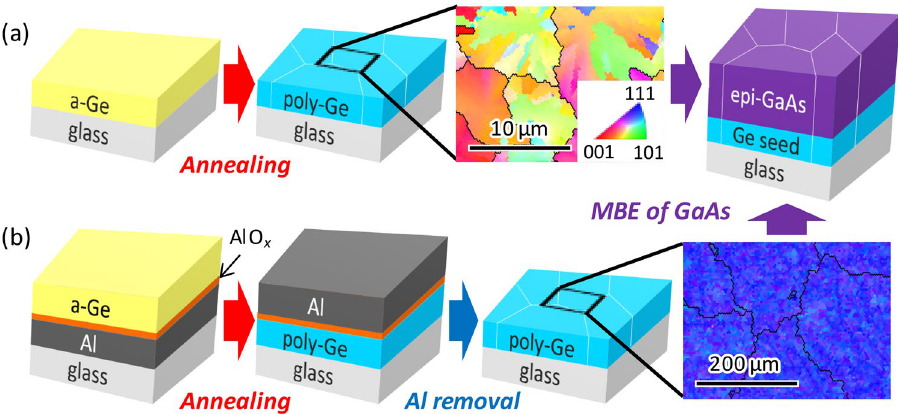
Figure 1. Schematic of sample preparation. ( a ) Samples in Groups A–C using SPC-Ge seed layers and ( b ) samples in Group D using ALILE-Ge seed layers. Representative crystal orientation maps of SPC-Ge (Sb-doped, T anneal = 375 °C) and ALILE-Ge ( t AE = 3 min) are shown in expanded views, where color scheme indicates crystal orientation (refer to legend in inset). Black solid lines in crystal orientation maps show grain boundaries surrounding grains.